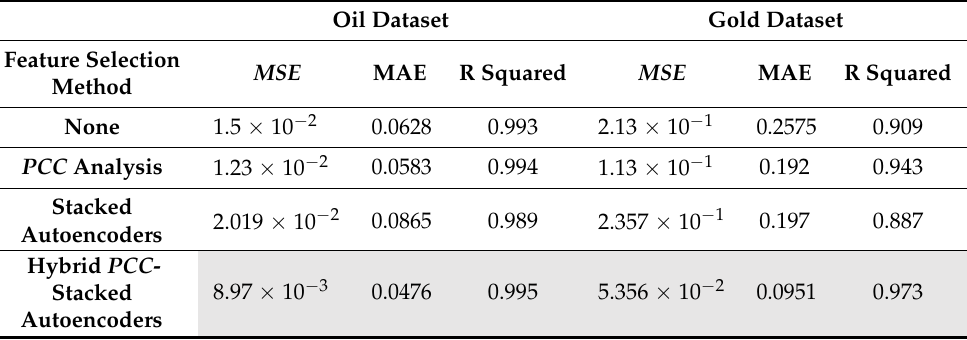
Table 4. The MSE , MAE, and R squared values for the NN regressor when trained on all features, the significant ones retrieved by the correlation analysis, the Stacked autoencoder, and Hybrid method for the oil, and gold,